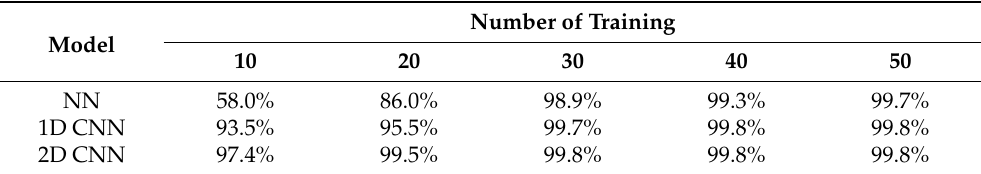
Table 7. Accuracy for NN, 1D CNN, and 2D CNN trained by using packet feature dataset.